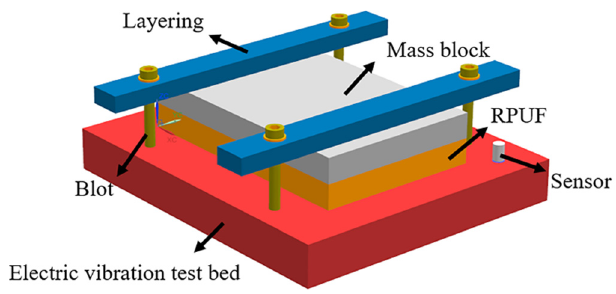
Figure 1. The random vibration testing system.